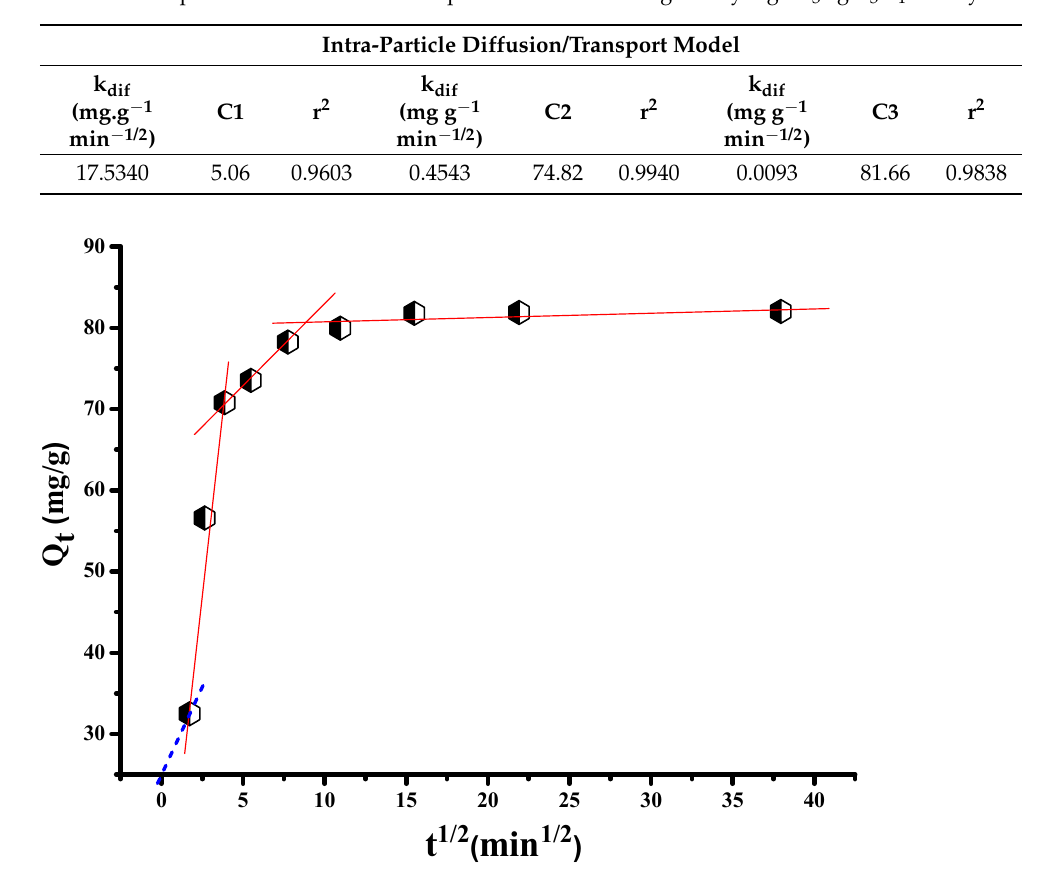
Figure 6. Adsorption mechanism investigation for removing RhB by MgTiO 3 @g-C 3 N 4 nanohybrid via the intraparticle diffusion model.